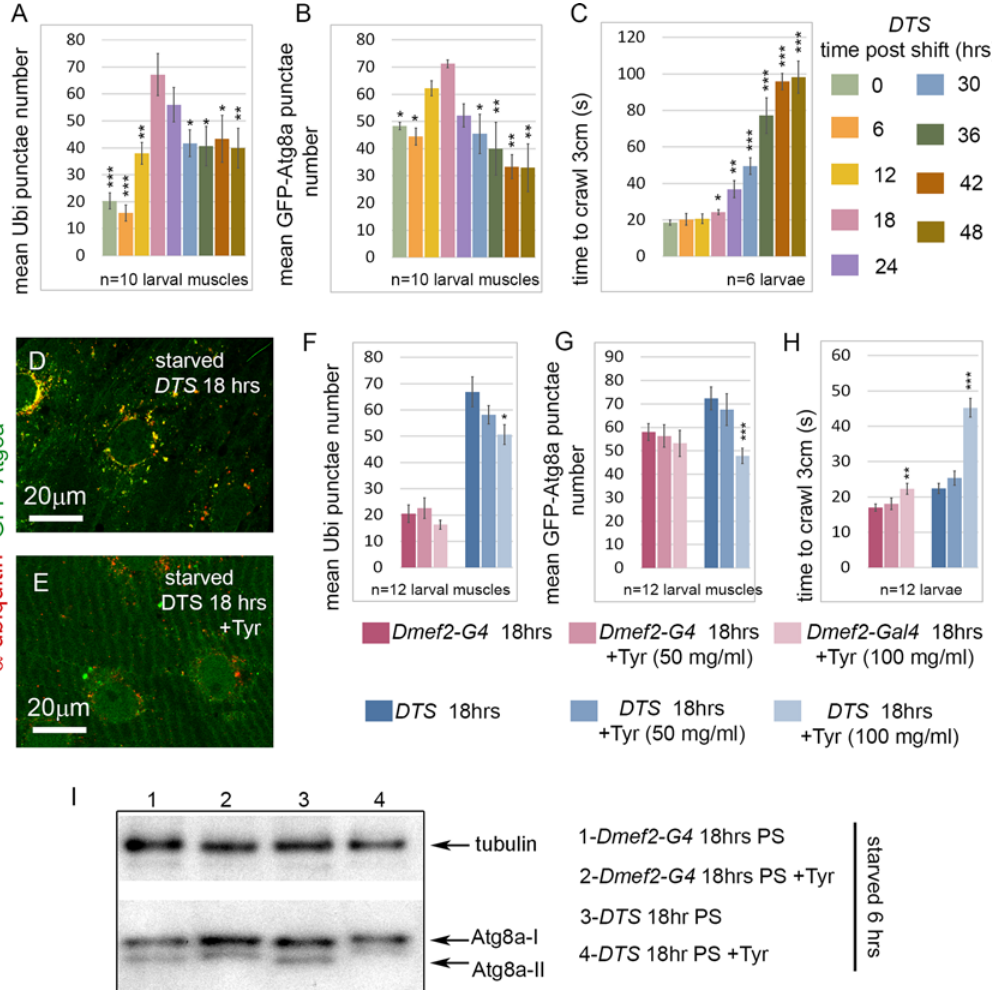
Fig 5. Tyramine (Tyr) treatment reduces autophagy induced by proteasome inhibition. (A-C) Time course of effect of temperature shift on aggregates, autophagosomes, and larval locomotion in UAS-DTS; Dmef2-Gal4 , UAS-GFP-Atg8a animals starved 6 hrs prior to analysis. (A) The number of ubiquitin aggregates peaks at 18 – 24 hrs PS, and decreases significantly from 18 to 48 hrs PS (n = 10 and p-values shown relative to 18 hrs PS). (B) The number of GFP-Atg8a punctae peaks at 12 – 24 hrs PS and decreases significantly from 18 to 48 hrs PS (n = 10 and p-values shown relative to 18 hrs PS). (C) Larval locomotion, measured as the time to crawl 3cm, gradually and significantly worsens from 18 to 48 hrs PS (n = 6 and p-values shown relative to 0 hrs PS. (D-E) tyramine (Tyr) treatment reduces GFP-Atg8a punctae in larval muscle. UAS-DTS; Dmef2-Gal4 , UAS-GFP-Atg8a animals were placed on 100mg/ml Tyr (D) or control food (E), shifted to restrictive temperature for 18hrs, and starved 6 hrs prior to dissection. (F-H) Effect of Tyr treatment on aggregates, autophagosomes, and larval locomotion in UAS-DTS; Dmef2-Gal4 , UAS-GFP-Atg8a and Dmef2-Gal4 , UAS-GFP-Atg8a animals, shifted to restrictive temperature for 18hrs, and starved 6 hrs prior to dissection. Aggregate (F) and GFP-Atg8a punctae (G) numbers in muscles are significantly reduced with 100 mg/ml Tyr treatment in DTS but not control animals 18 hrs post-shift (PS). (H) 100 mg/ml Tyr treatment significantly worsens larval locomotion in both control and DTS animals 18 hrs PS. n = 12 and p-values shown relative to non-Tyr treated animals. For all measurements, SEM is shown with * p < .05; ** p < .01; *** p < .001. (I) Western blot analysis of endogenous Atg8a from third instar muscle lysate 18 hrs PS. 6 hrs starvation induces lipidated Atg8a-II in Dmef2-G4 control with or without 100 mg/ml Tyr. After 6hrs starvation, Atg8a-II levels are reduced in DTS + 100 mg/ml Tyr relative to untreated DTS